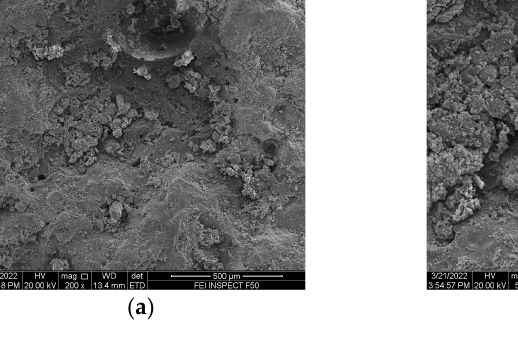
Figure 7. SEM surface morphology of steel slag aggregates: ( a ) ×200 Magnification; ( b ) ×500 Magni- fication; ( c ) ×1000 Magnification.